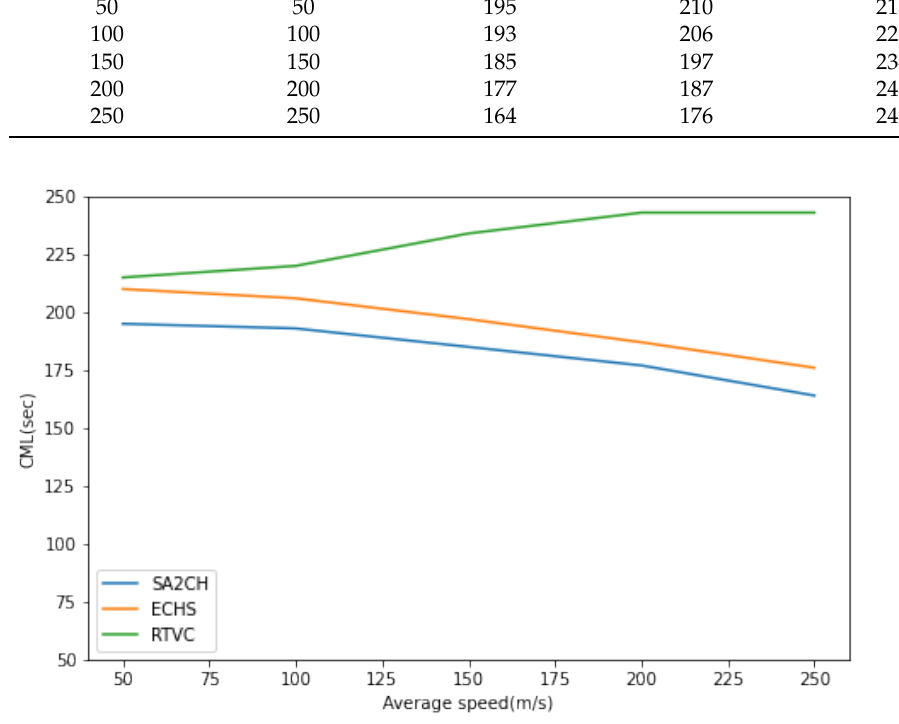
Figure 8. Comparative graph of CML between the existing and proposed